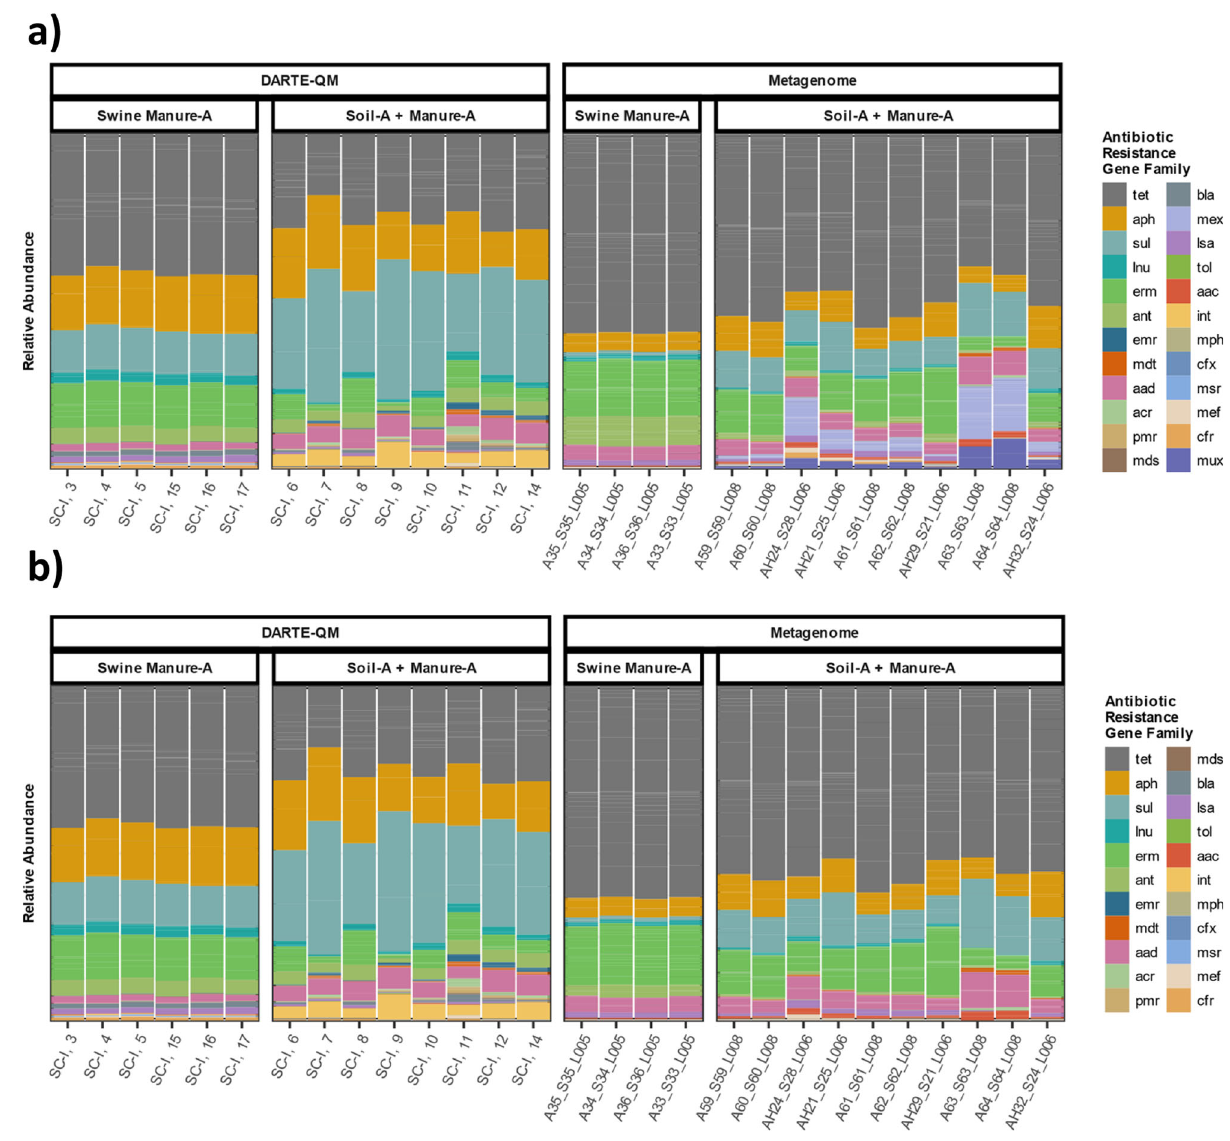
Fig. 5 Comparison of ARGs captured by DARTE-QM and metagenome analyses. a Distribution of all ARG families detected by DARTE-QM and metagenomes for the DNA originating from swine-manure (Swine Manure A) and swine-manure-amended soils (Soil-A + Manure-A). b Distribution of only ARG families targeted by DARTE-QM detected by both DARTE-QM and metagenomes for the same